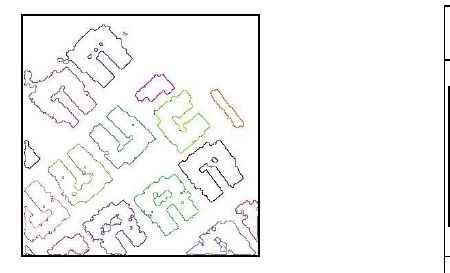
Figure 7: result of contours extraction process.